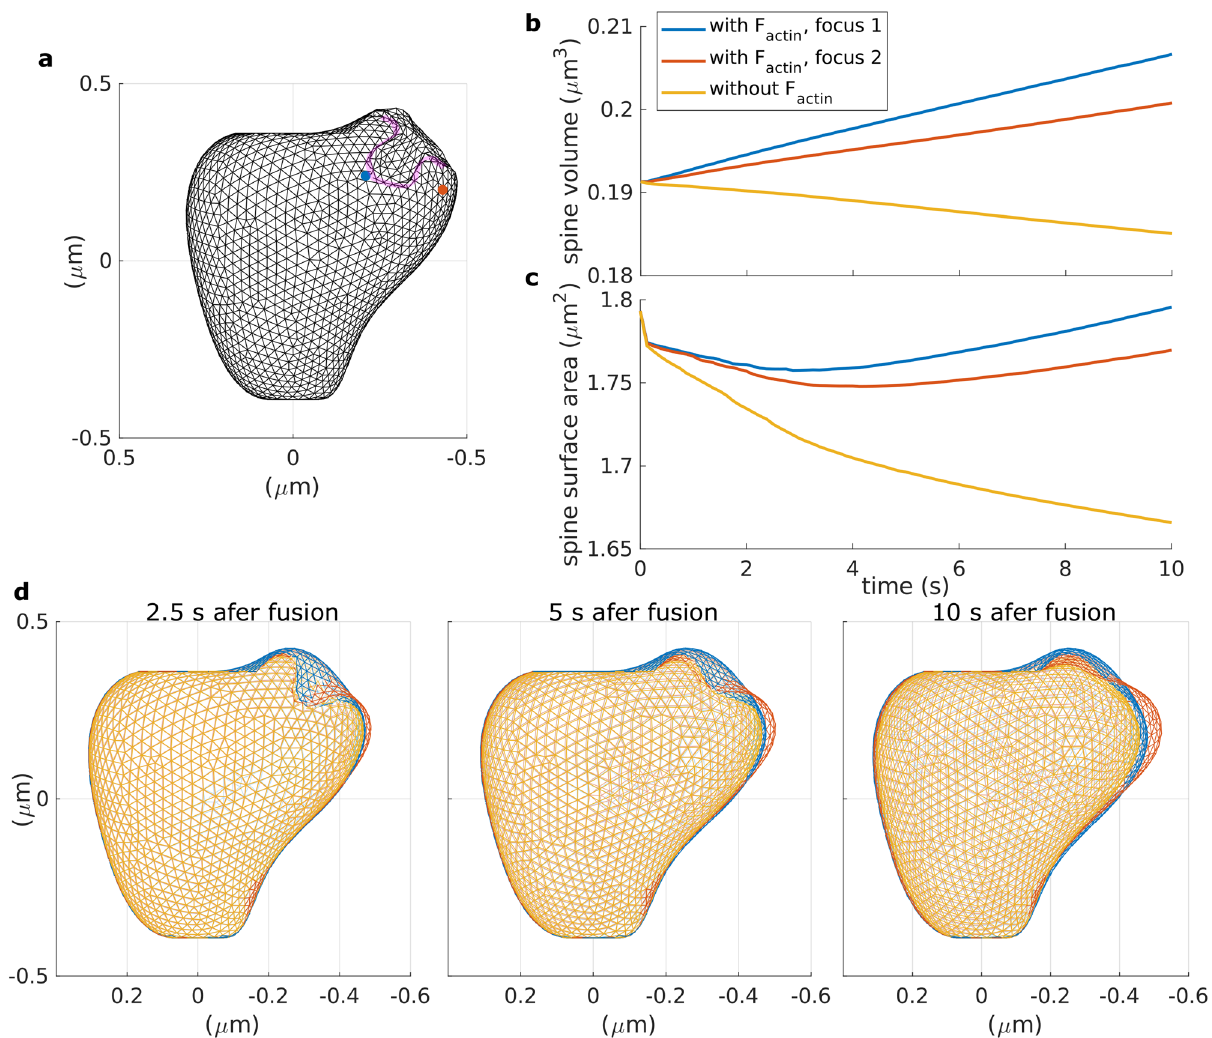
Figure 4. Exocytosis with and without the aid of F-actin polymerization. ( a ) Dendritic spine membrane after fusion with a recycling endosome. The invagination, highlighted in magenta, is the (cid:31) -profile formed after the fusion event. The blue and orange dots represent the distinct F-actin polymerization foci. ( b ) Spine volume evolution over time, color-coded depending whether the (cid:31) -profile merging is aided by F actin or not. ( c ) Spine area surface evolution over time, color-coded as in ( b ). ( d ) Snapshots taken at different times after initiation of spine membrane fusion with the recycling endosome, color-coded as in ( b